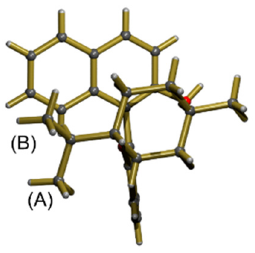
Figure 2. Single-crystal structure of stereoisomer 3 , showing different chemical environments of isopropyl group methyl protons (A and B).